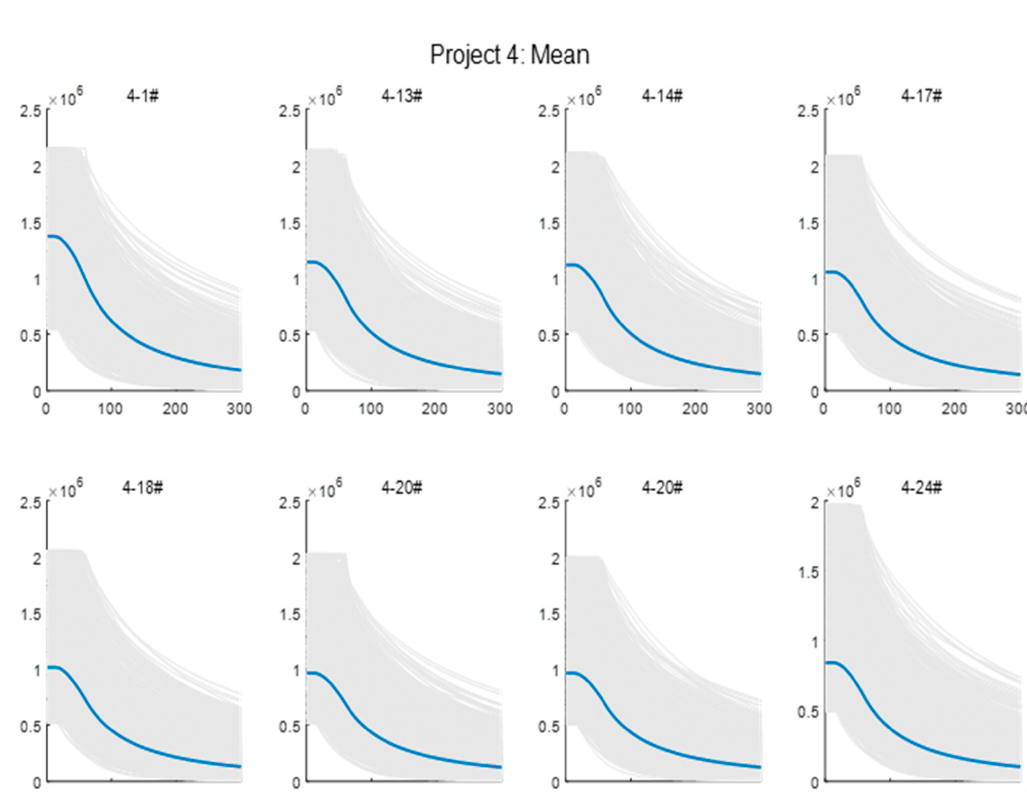
Figure 7. Production plan of project 4.